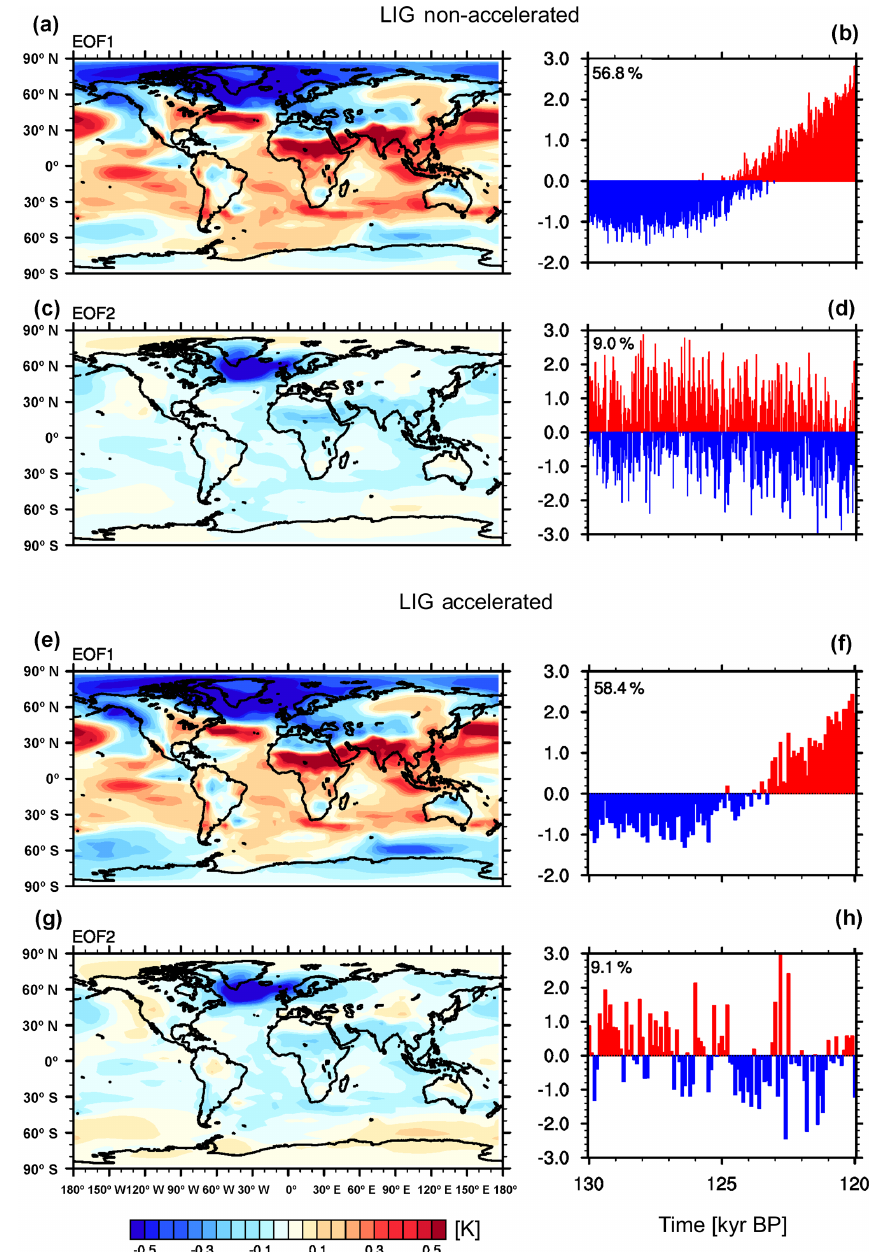
Figure 7. Same as Fig. 5 but for LIG surface